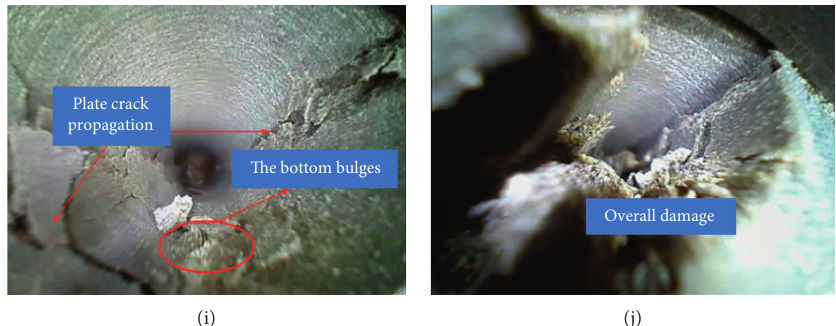
� 28.13MPa), (b) 18 ′ 45.37 ″ ( σ � 34.64MPa), z z